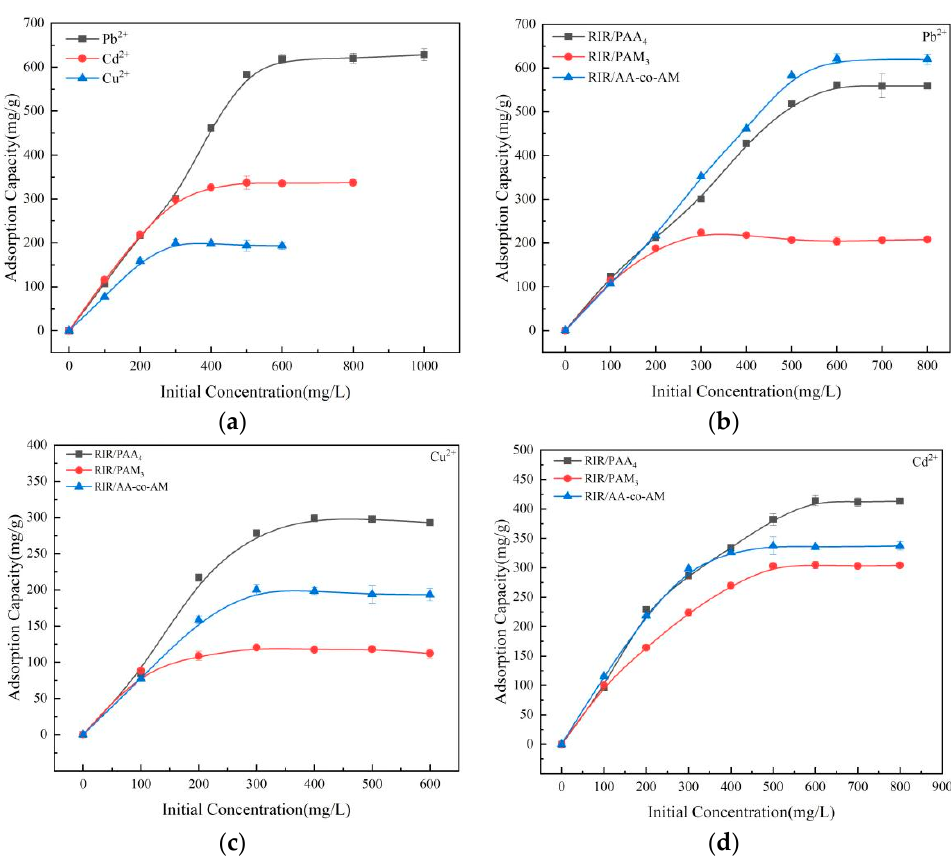
Figure 9. Effect of initial concentration on Pb 2+ , Cu 2+ , and Cd 2+ adsorption. Adsorption conditions were at absorbent = 0.02 g, T = 25 °C, pH = 3 for RIR/AA-co-AM, pH = 4 for RIR/PAA 4 and RIR/PAM 3 , and t=8 h. Adsorption capacity of RIR/AA-co-AM for Pb 2+ , Cd 2+ , and Cu 2+ ( a ); Adsorption capacity of three hydrogels for Pb 2+ ( b ); Adsorption capacity of three hydrogels for Cu 2+ ( c ); Adsorption capacity of three hydrogels for Cd 2+ ( d ).